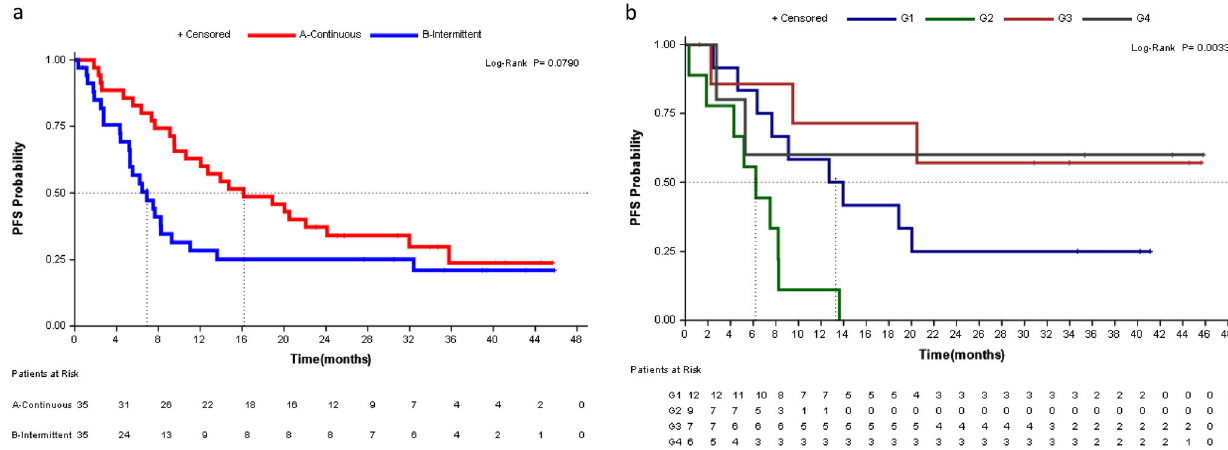
Fig. 2 Progression Free Survival. A PFS according to treatment arm ( n 70); B PFS according to treatment arm and BRAF mutation in cfDNA ( n 34). G1: Continuous arm and basal BRAF Positive in cfDNA, G2: Intermittent arm and basal BRAF Positive in cfDNA, G3: Continuous arm and basal BRAF Negative in cfDNA, G4: Intermittent arm and basal BRAF Negative in cfDNA.